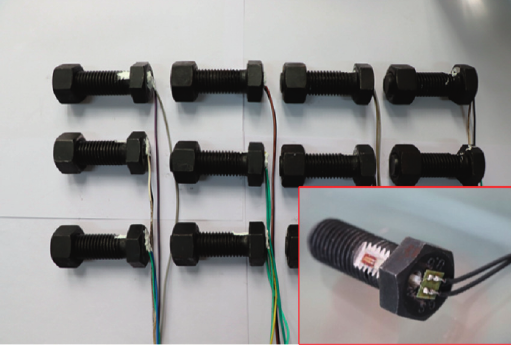
Figure 24: Strain gauge affixed to bolts.